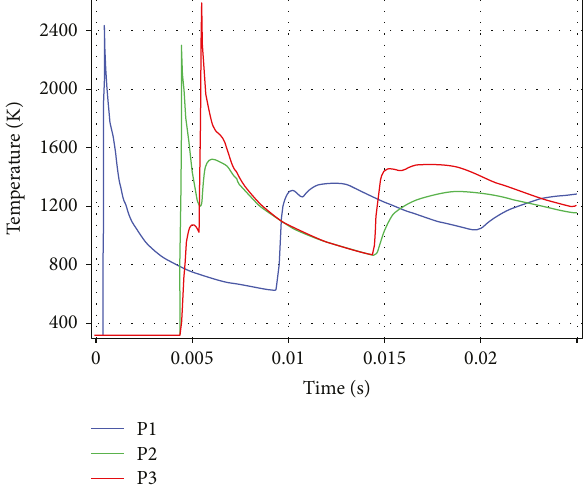
Figure 10: Temperature variation curves of P2, P4, and P5.